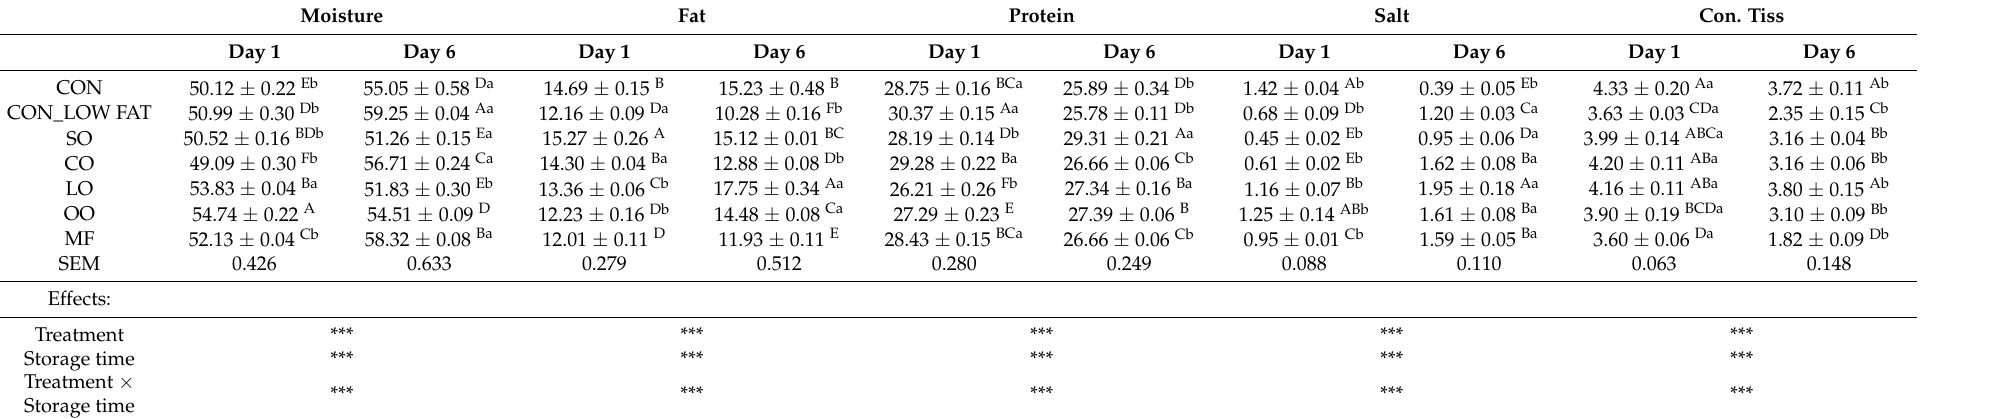
CON—control group beef burgers, CON_LOW FAT—burgers with reduced fat, burgers with fat substitutions, i.e., sunflower oil (SO), canola oil (CO), linseed (LO), olive oil (OO)